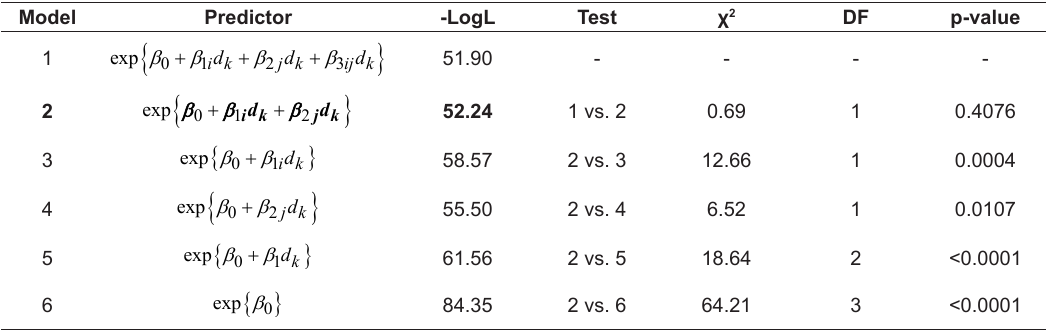
Table 3. Likelihood ratio tests for the different models fitted to the data of the experiment involving E. grandis and M. aquifolium .